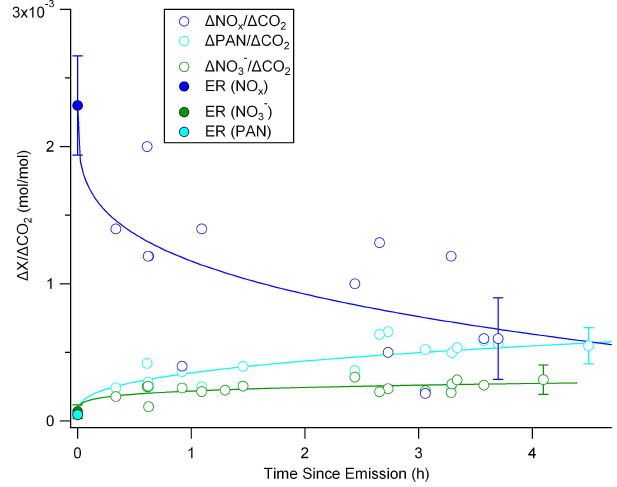
Fig. 9. 1 NO x (blue), 1 PAN (light blue), and 1 NO − tioed to 1 CO 2 (molar) vs. time since emission (h). Corresponding emission ratios (ER) are shown as solid blue, light blue, and green circles, respectively. ER error bars show the standard deviation in the mean of the ten source measurements. The ER(PAN) error bar is too small to be visible. Downwind error bars are an estimate of the uncertainty in oldest individual downwind samples. Points were fit to logarithmic